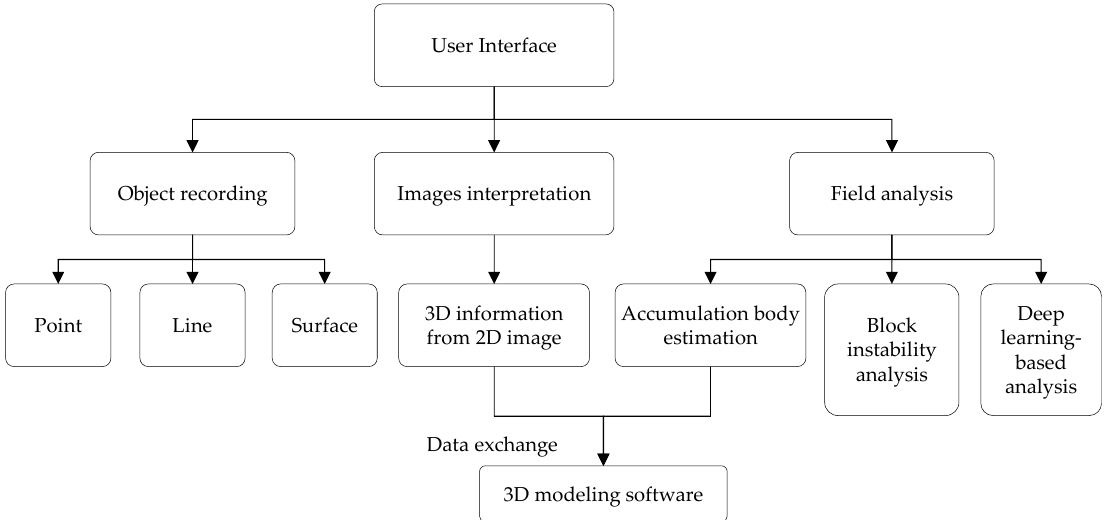
Figure 6. The architecture of modules.